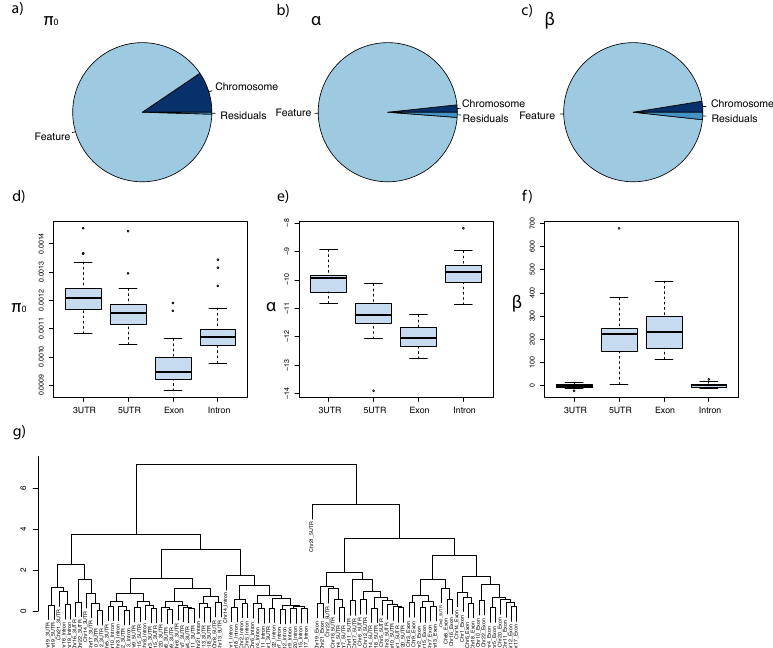
Figure 1. Effect of long-term evolutionary rates and recombination on shaping genetic diversity. π 0 represents the level of the intrinsic genetic diversity. Selection on a genomic locus reduces the genetic diversity at the locus. Hitchhiking propagates the effect of selection on the surrounding region. We described the selective effect ( sh i ) on a gene in terms of the long-term molecular evolutionary rate ( r i ) as sh i = exp ( α + β r i ) (see Materials and Methods). Parameter α describes the impact of recombination relative to long-term rate in the model. Higher α values in genomic regions indicate that recombination contributed more to the prediction of genetic diversity than the regions with lower α values. β describes the impact of the long-term rates of nearby genes. Higher β values in genomic regions indicate that the long-term rates of genes contributed more to genetic diversity than the regions with lower β values. The three parameters were estimated for each chromosome and for each feature (3 (cid:48) -UTR, 5 (cid:48) -UTR, exon, or intron). In total, we obtained 88 (22 chromosomes × 4 features) estimates each for π α , and β . ( a – c ). Pie charts for π α , and β , respectively, 0 , 0 , representing the contributions of chromosome, feature, and residuals. The variances of π 0 , α , and β were decomposed into among-chromosome variances, among-feature variances, and variances of residuals in two-way ANOVA that represented the interactions of each set of factors. ( d – f ). The among-chromosome variations of π 0 , α , and β , respectively, for each feature (3 (cid:48) -UTR, 5 (cid:48) -UTR, exon, or intron). ( g ). Hierarchical clustering of π 0 , α , and β for each chromosome and feature. We normalized the values of π 0 , α , and β to analyze the three parameters